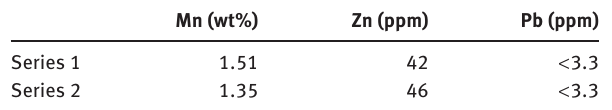
Table 1 Weight concentrations for the two series of Cu-Mn single crystals determined by ICP mass